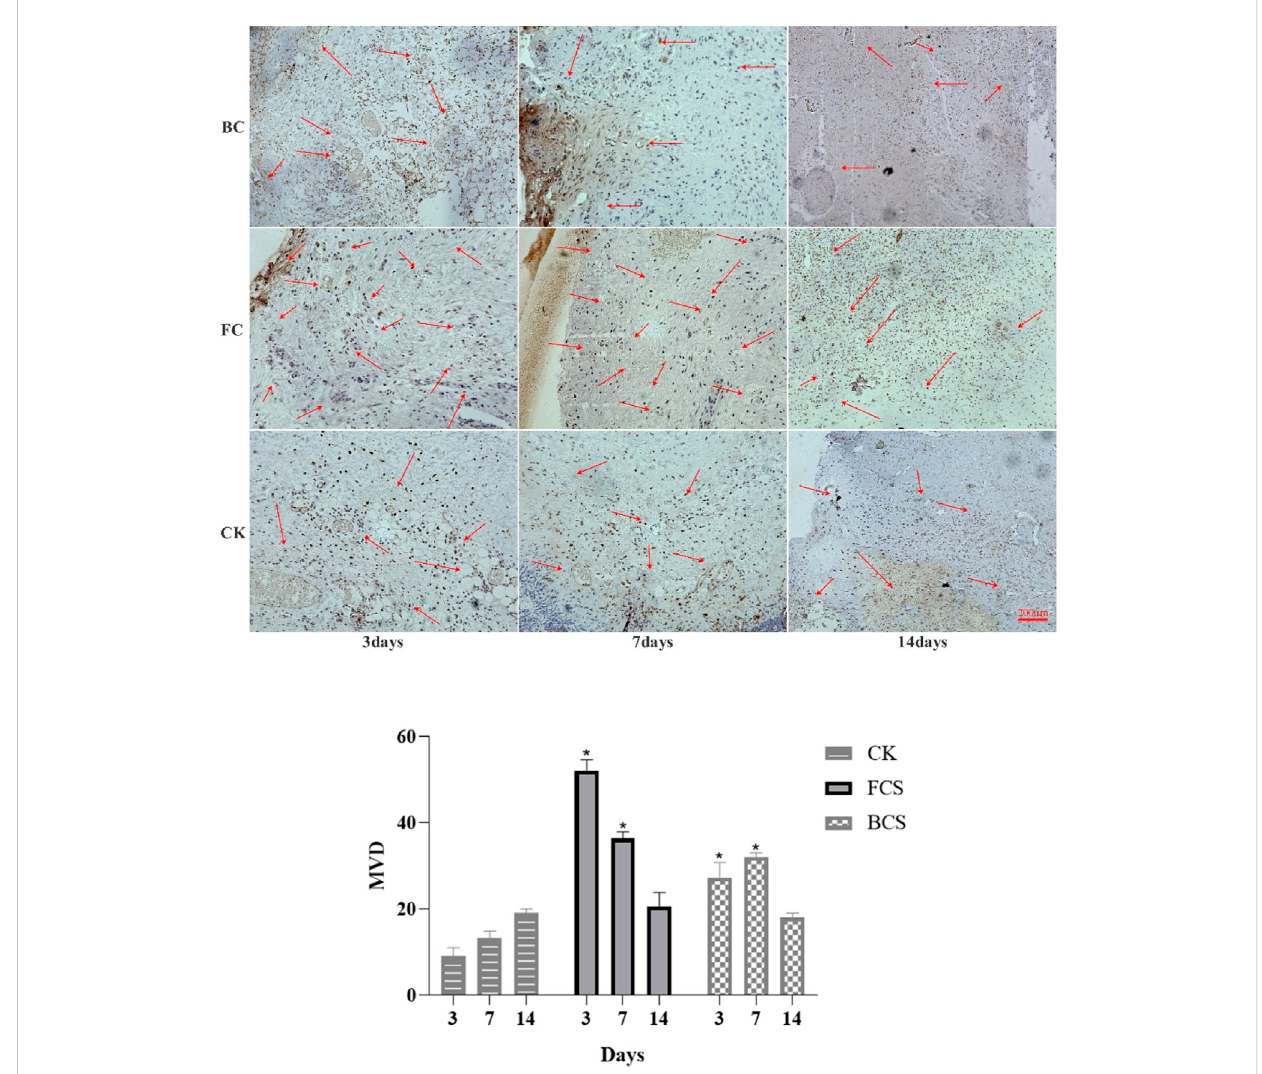
FIGURE 5 Immunohistochemical analysis of VEGF expression in wounded tissues (Magni fi cation, ×100). The red arrow shows the new blood vessel. The histogram summarizes the microvessel density (MVD), which was determined by immunohistochemical staining for VEGF. (Each bar represents the mean ± SD. * p < 0.05: signi fi cantly different from the control